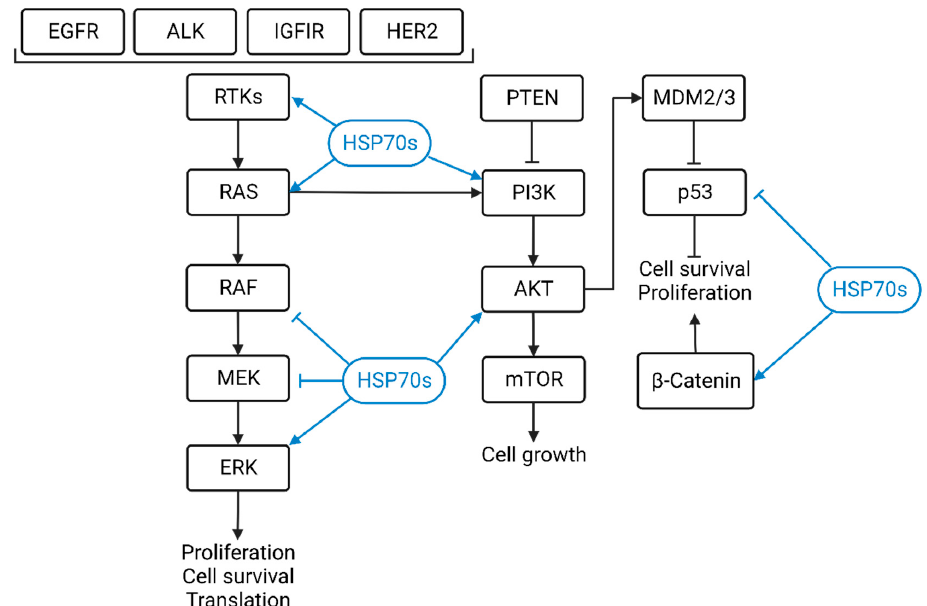
Figure 2. Schematic diagram of cancer related signaling pathways regulated by HSP70s. HSP70 family members regulate important phenotypes such as tumor cell survival and proliferation by regulating a variety of key proteins in cancer-related signaling pathways.